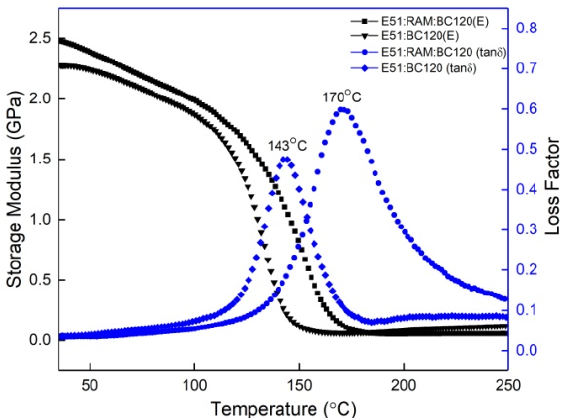
Figure 10. DMA curves for resin cast samples with or without the hardener.